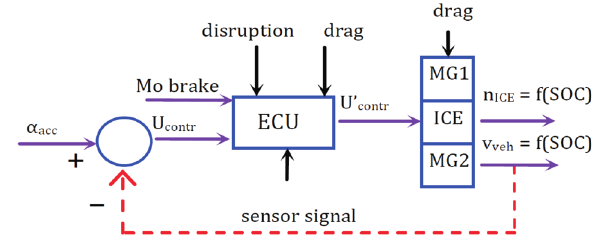
Fig. 5. The algorithm of the tested vehicle control with a possible to apply feedback